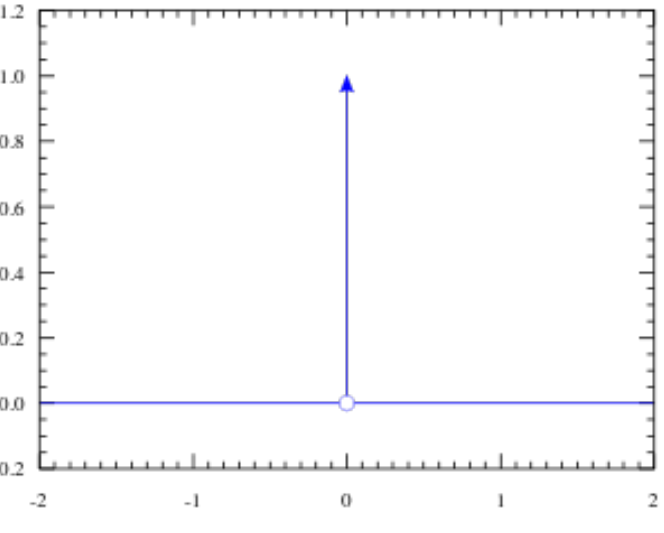
Figure 2. The Dirac impulsive